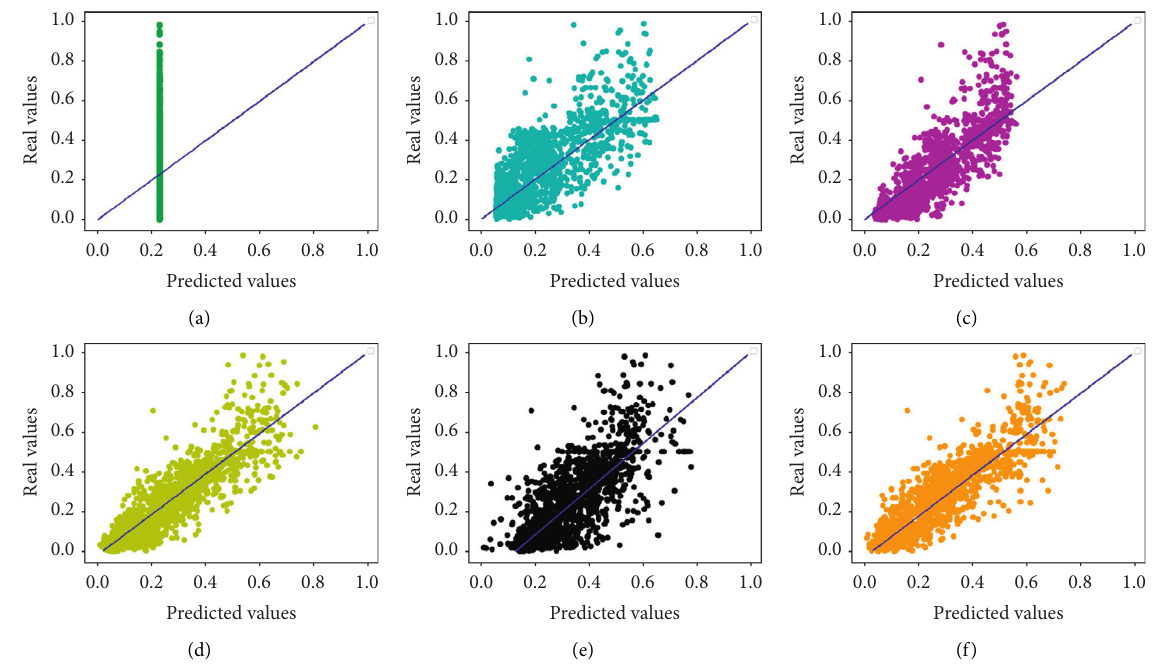
Figure 14: The scatter plot of the forecast and observed inflow for 24h lead times. (a) SVR, (b) DBN, (c) RFR, (d) GBRT, (e) LSTM, (f)